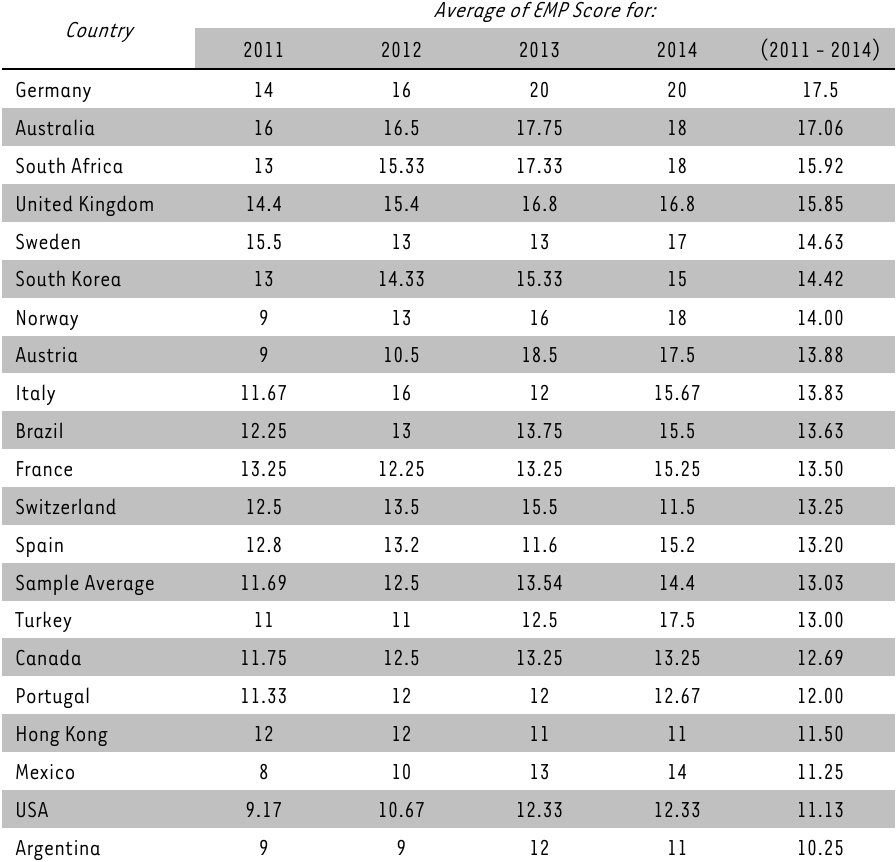
Average of EMP Score